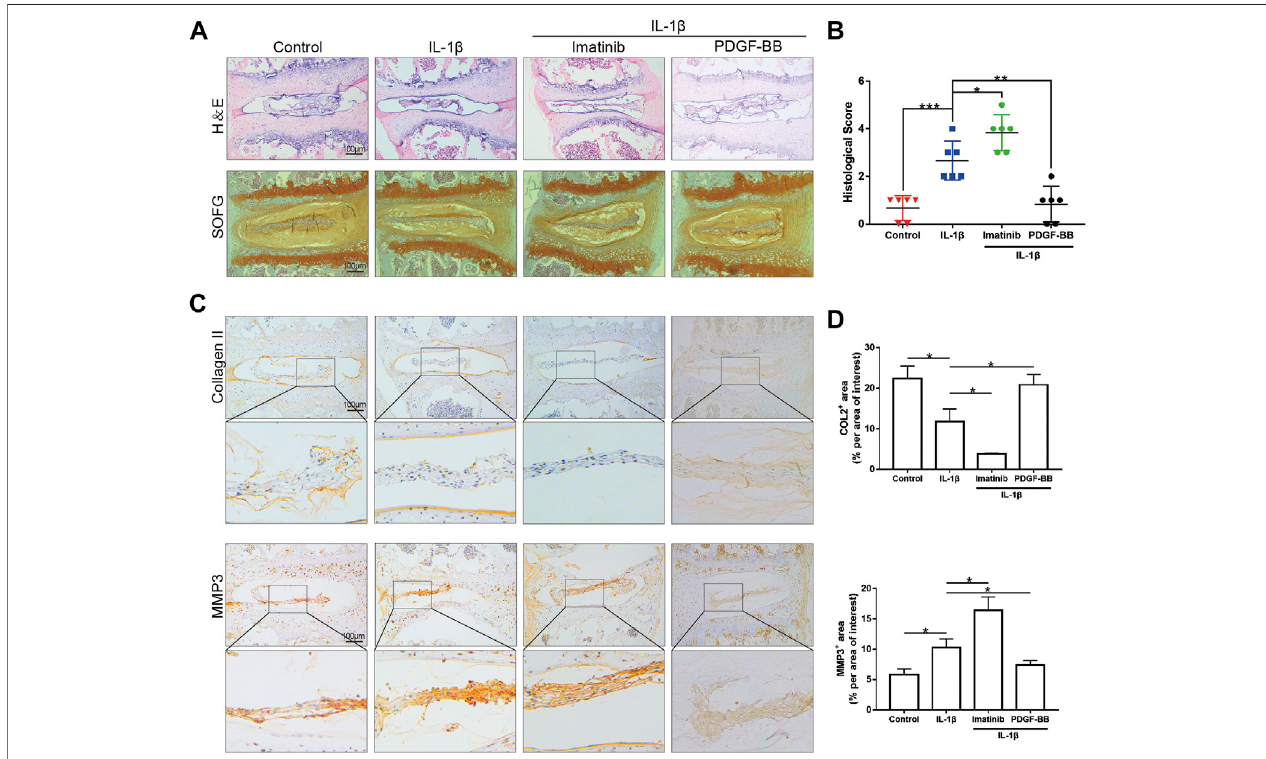
FIGURE 2 | PDGF-BB inhibits the degeneration of organoids cultured in vitro . (A) Hematoxylin and eosin staining and Safranin O-Fast green staining of intervertebral disc cultured in vitro . n (cid:1) 6. Scale bar, 100 μ m. (B) Histologic score of intervertebral disc in each group. (C) Immunohistochemical images of COL2 and MMP3 of intervertebral disc. n (cid:1) 6. Scale bar, 100 μ m. (D) Average percentage of positive staining area of intervertebral disc in each group. Data are presented as the mean ± SD. Signi fi cant differences between groups are indicated as *** p < 0.001, ** p < 0.01, * p <